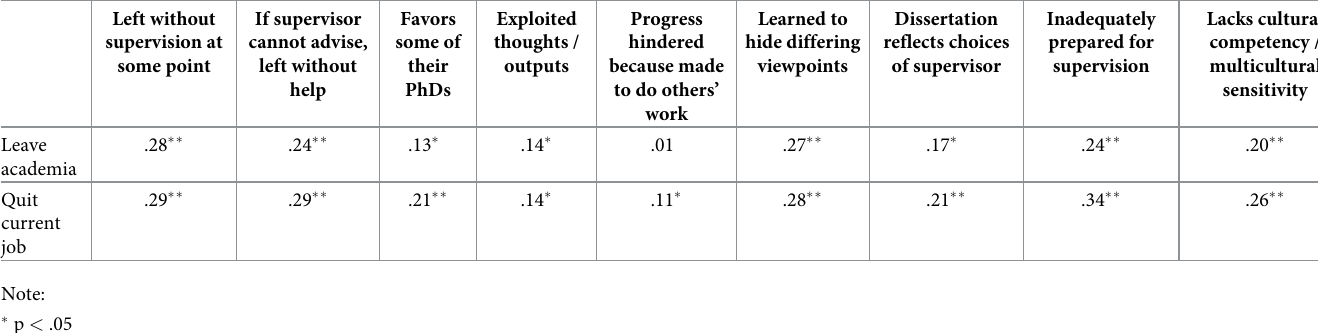
Table 6. Spearman correlations for supervision items and leave/quit considerations (positive correlation). Left without supervision at some